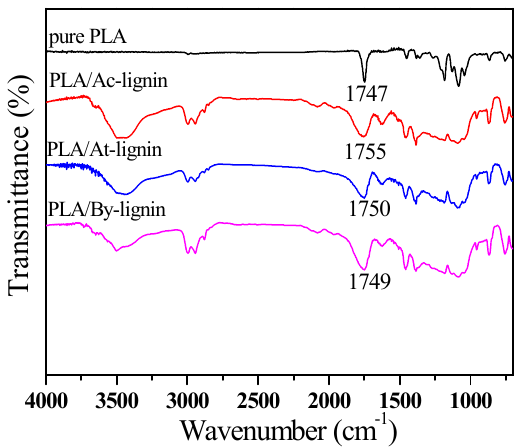
Figure 6. FTIR spectra of pure PLA, PLA/Ac-lignin, PLA/At-lignin, and PLA/By-lignin.